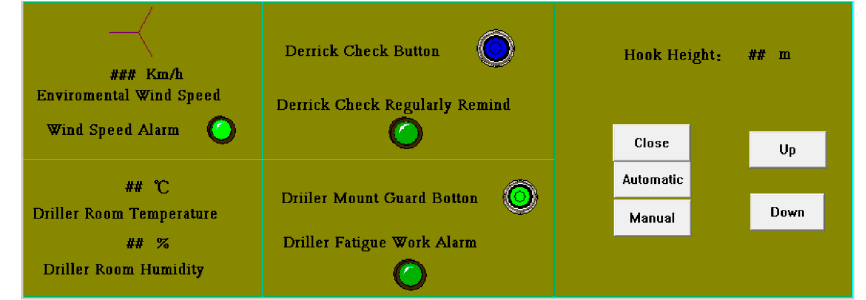
Figure 7. Monitoring configuration screen of derrick and driller room.